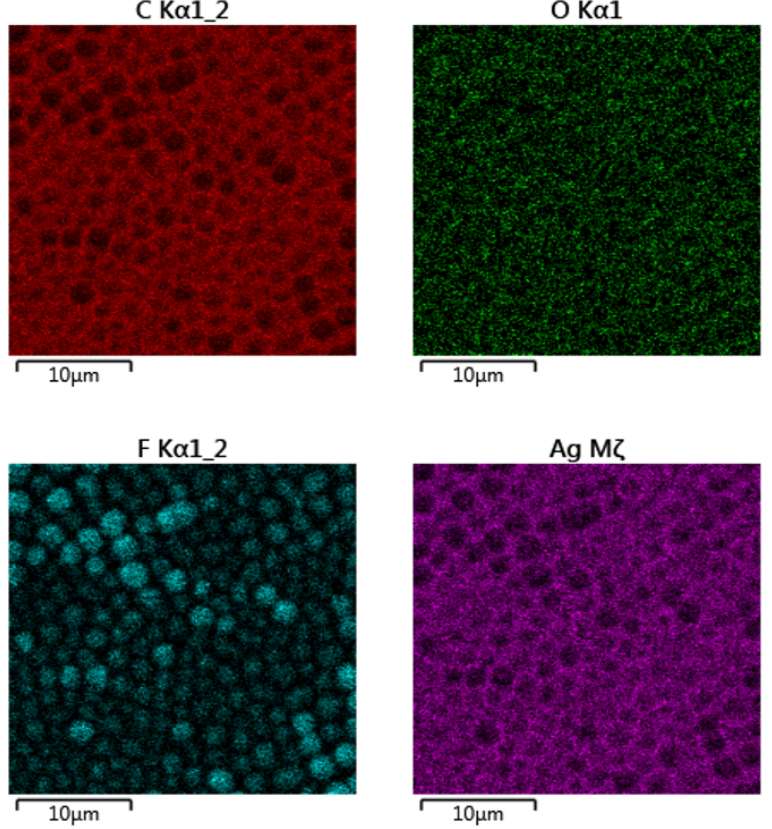
Figure 7. EDS mapping channels for carbon, oxygen, fluorine, and silver of the immobilized honey- comb polystyrene pattern; 30 micron scans are presented.